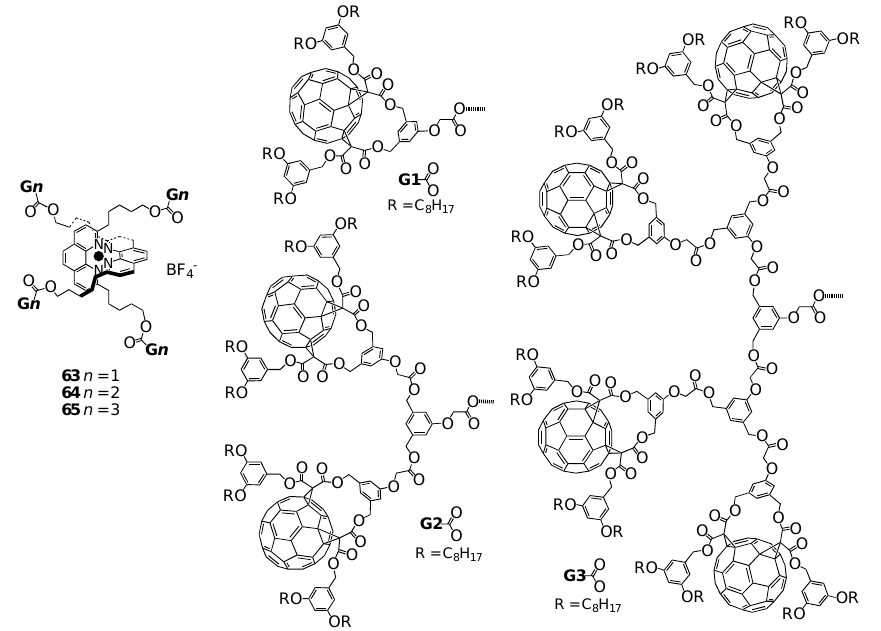
Figure 9. Structures of G1 to G3 fullerene-rich Cu(II) phenanthroline-based metal complexes 63 - 65